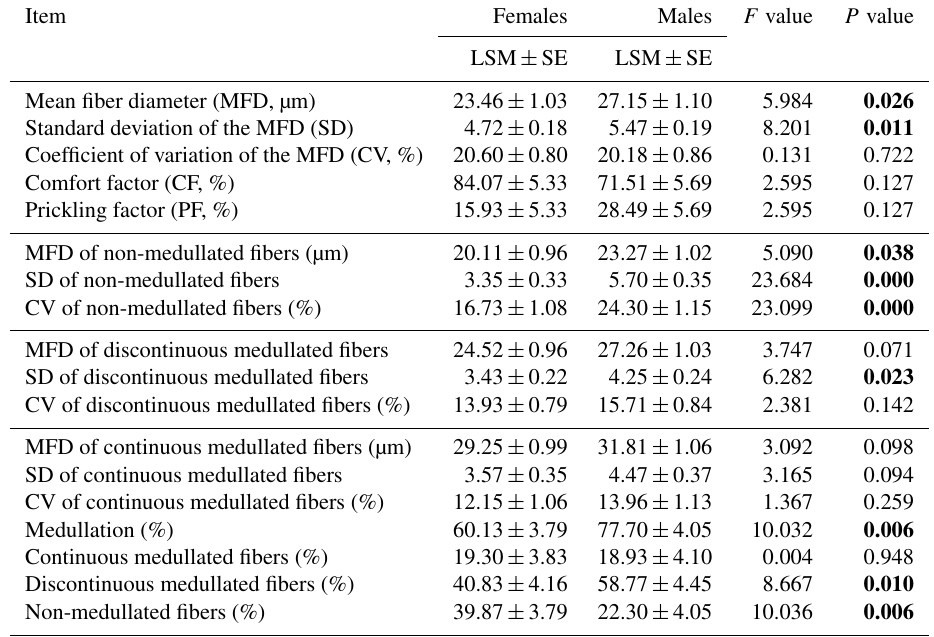
LSM represents the least squares mean, and SE represents the standard error.